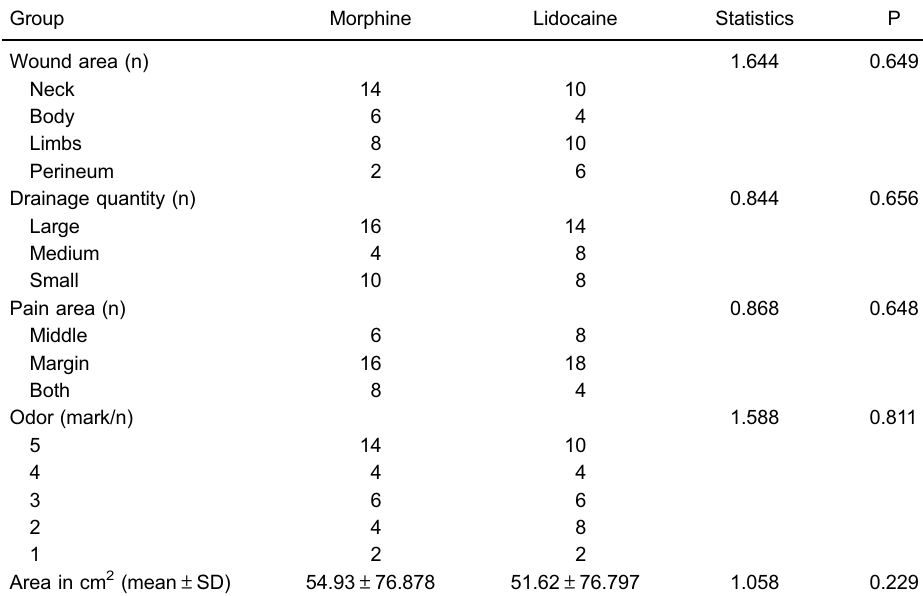
Table 1. Basic information of wounds in the two groups of patients receiving systemic morphine or topical compound lidocaine for cancer wound dressing change.